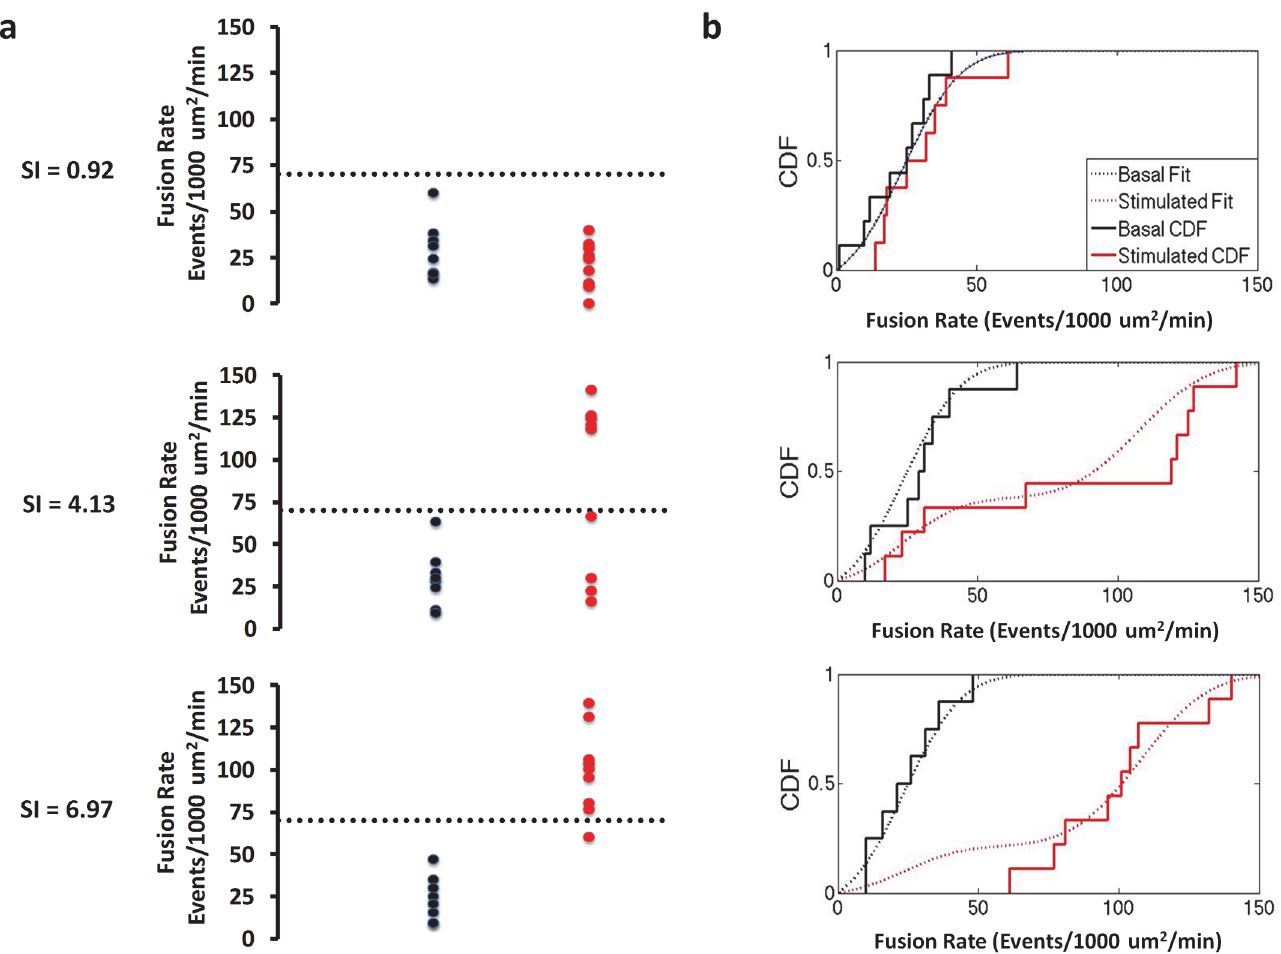
Fig 6. Representative “ Bee swarm ” plots (a) and empirical cumulative distribution functions (b) for basal (black) and insulin-treated (red) GSV fusion rates measured in adipose cells isolated from subjects with varying degrees of insulin sensitivity reveals two populations at the individual subject level. Dashed lines represent cluster boundaries calculated using the K-means clustering function. At low SI both the basal and insulin stimulated distributions are fit by a single, basal function. With increasing SI, increasing number of cells shift from the basal into the insulin-stimulated state characterized by high fusion rate (greater than 70 Events/1000 μ m 2